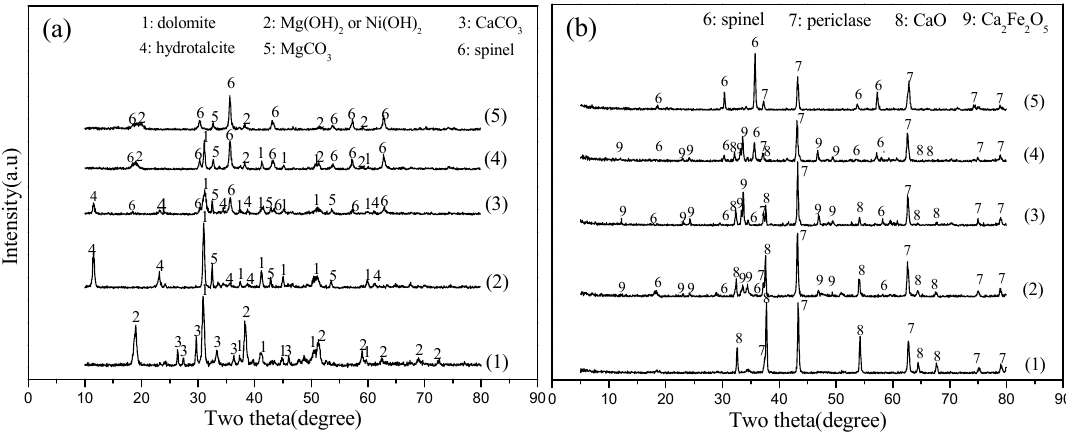
Figure 3. X-ray diffraction (XRD) patterns of Ni-based catalysts of ( a ) precursors and ( b ) oxides after calcination at 800 °C. (1) MNC 0.8 F 0.0 ; (2) MNC 0.7 F 0.1 ; (3) MNC 0.5 F 0.3 ; (4) MNC 0.3 F 0.5 ; and (5) MNC 0.0 F 0.8 .